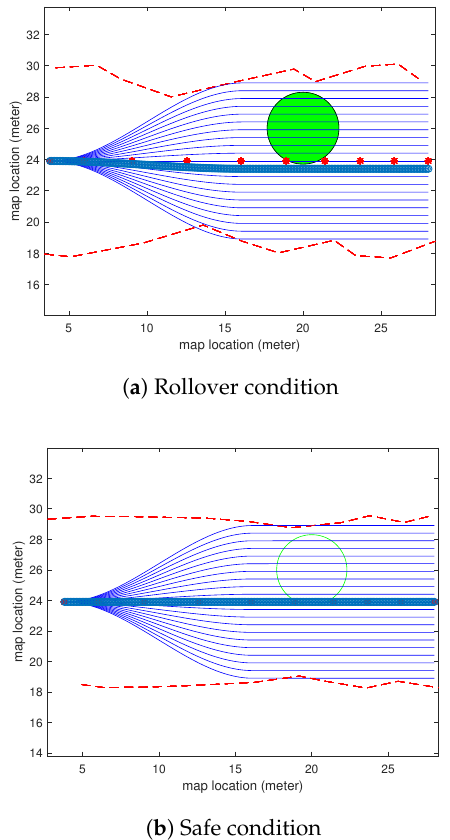
Figure 9. Single obstacle path selection: ( a ) path candidate selection under a single pit with rollover risk; ( b ) path candidate selection under a single pit without rollover